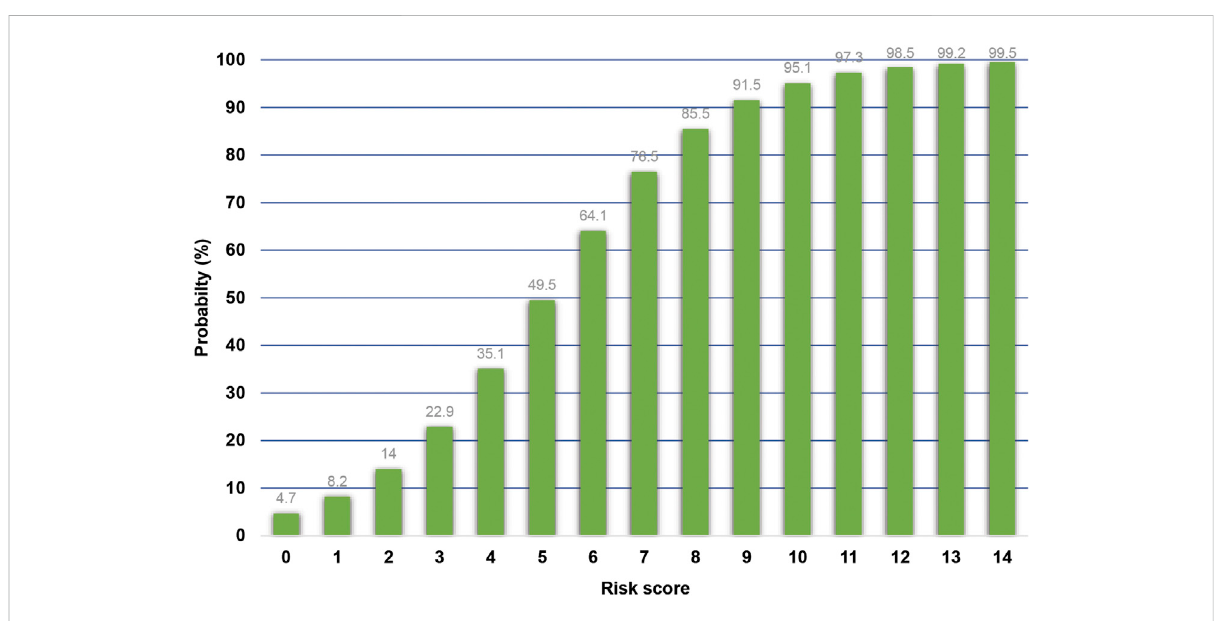
FIGURE 5 Probability of mortality in patients with MDROs strati fi ed by the